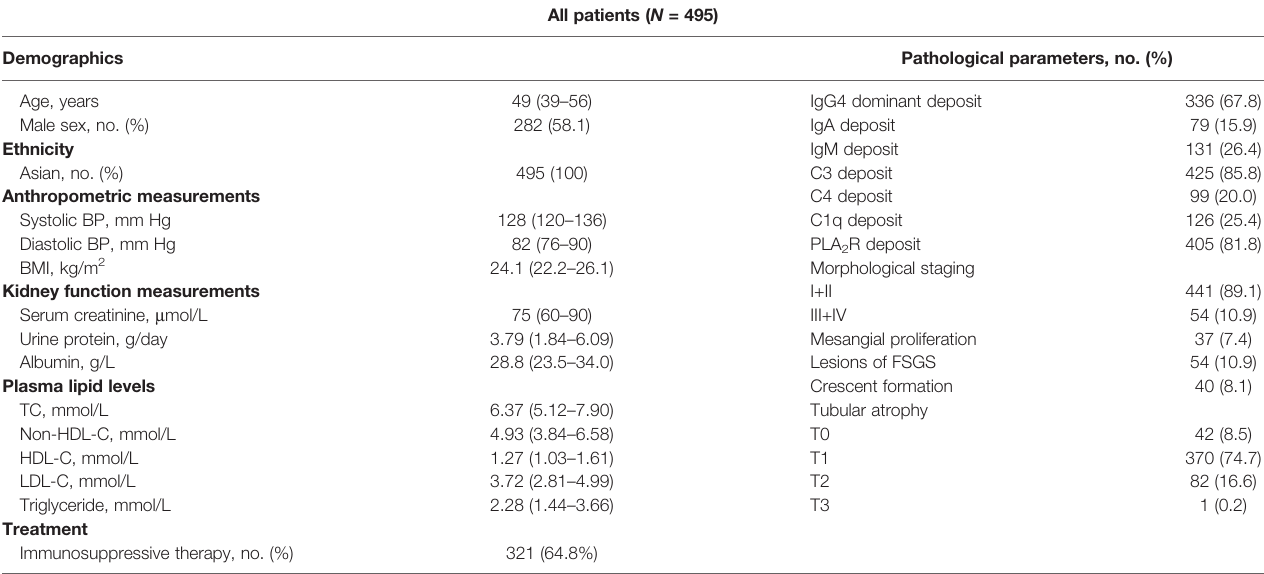
TABLE 1 | Baseline characteristics of idiopathic membranous nephropathy